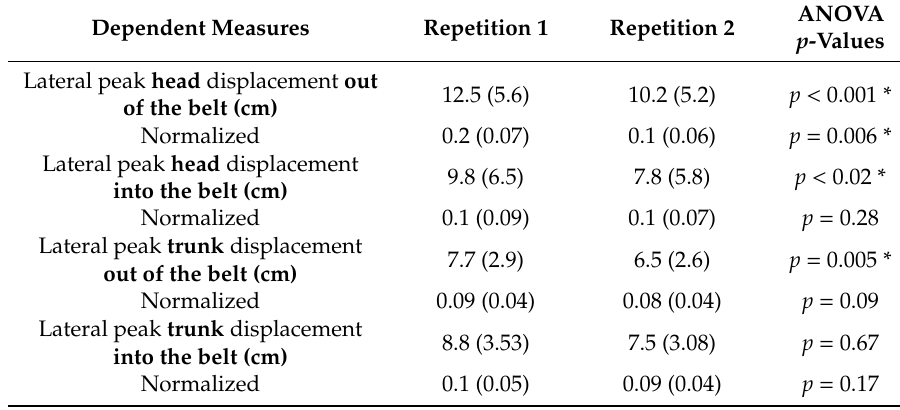
Table 4. Mean (SD) of normalized and non-normalized kinematic outcome measures: e ff ect of